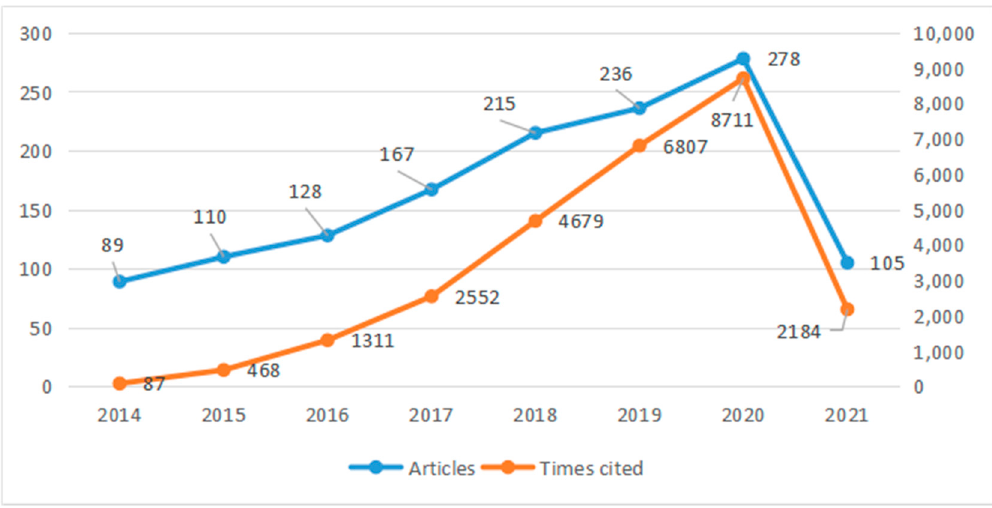
Figure 7. Yearly distribution of articles and total citation numbers (2014–2021).